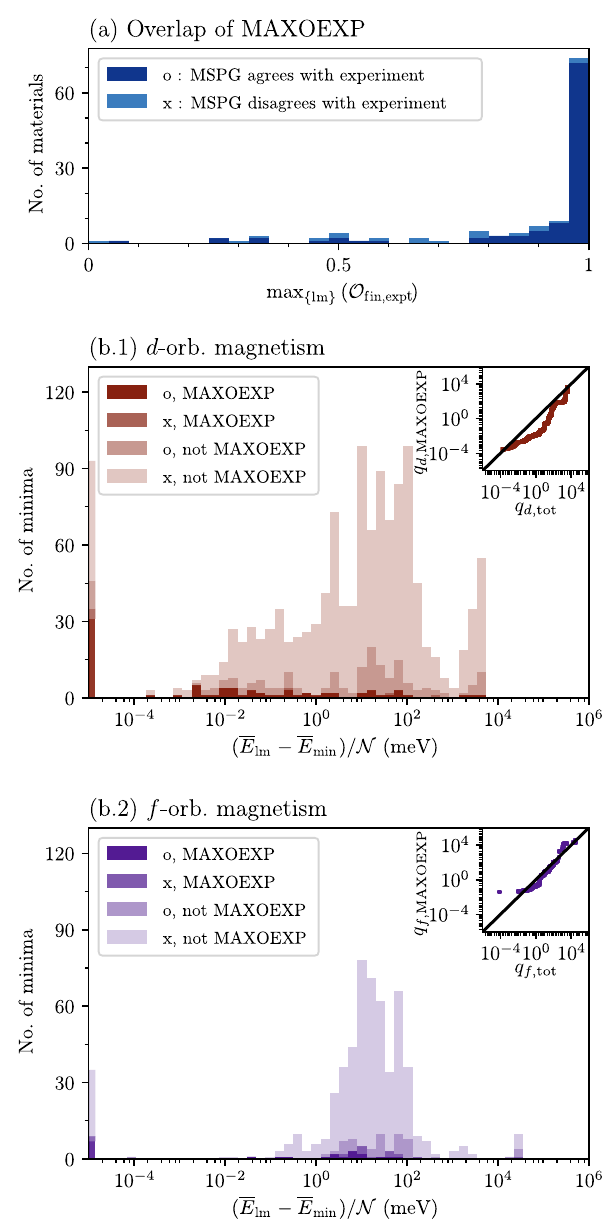
FIG. 4. (a) Overlap of experiment and CMP þ SDFT minimum most similar to experiment (MAXOEXP). Overlap is defined in Eq. (12). o or x classifies if the magnetic space group (MSPG) agrees or disagrees with the experimental MSPG. (b.1) Total energy distribution with respect to materials feature d -orbital magnetism. The minima are classified in MAXOEXP and remainder “ not ” MAXOEXP, and MSPG agrees or disagrees. Inset: Q − Q plot, where q with respect to the dis- d; MAXOEXP tribution of MAXOEXP is compared to q with respect to the d; tot distribution of all local minima of materials feature d -orbital magnetism. (b.2) Total energy distribution with respect to materials feature f -orbital magnetism. Inset: Q - Q plot, where q with respect to the distribution of MAXOEXP is f; MAXOEXP compared to q with respect to the distribution of all local f; tot minima of materials featuring f -orbital